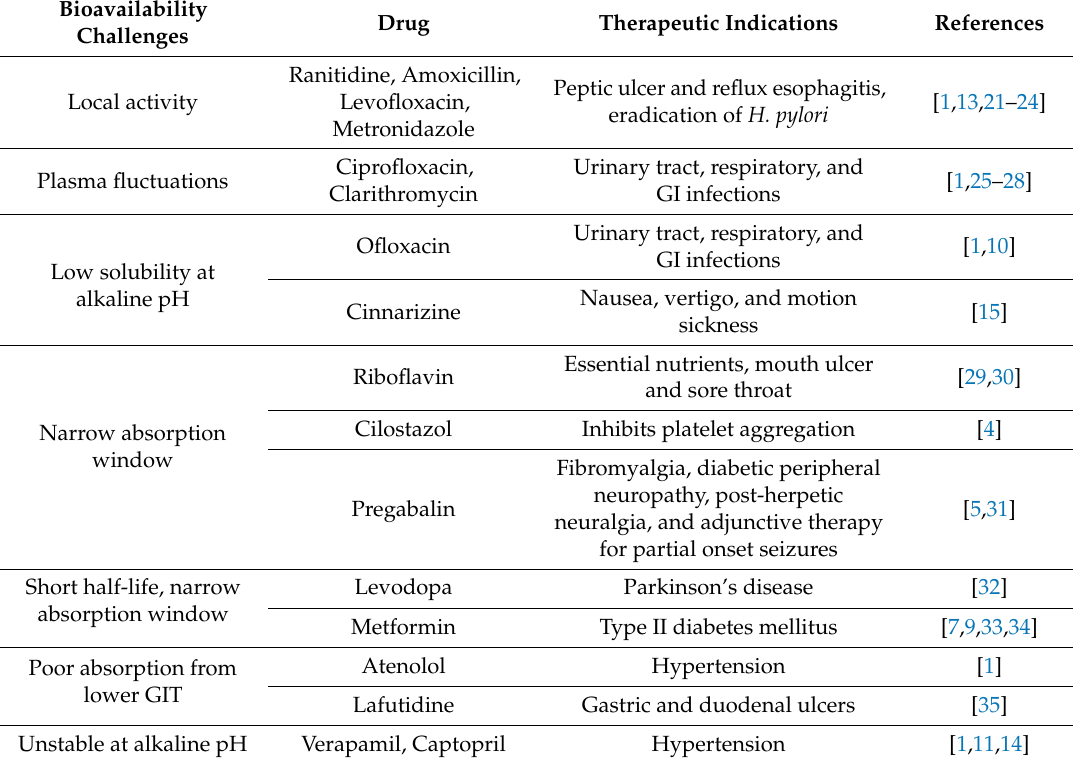
Table 2. Suitable drug candidates for gastroretentive drug delivery systems (GRDDS).